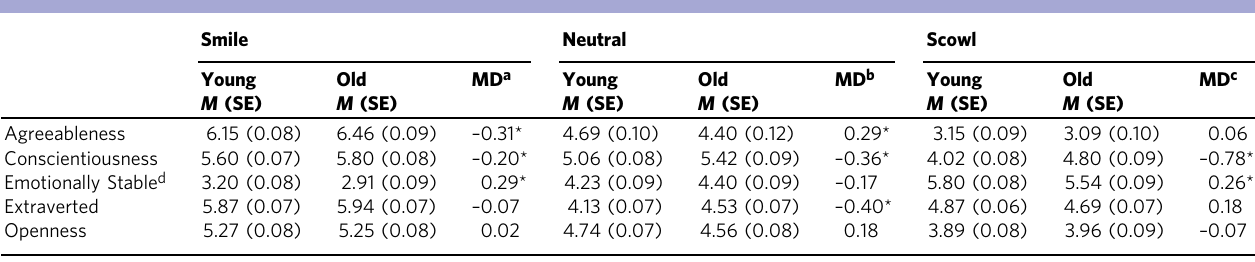
Table 6 Facial expression x age, Big-Five personality traits ( M , SE, Mean difference).